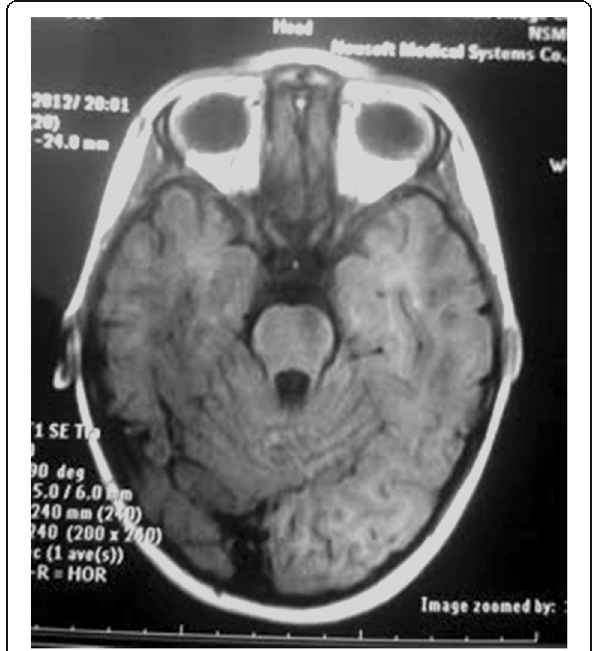
Fig. 2 MRI image of Patient II. It indicates mild cerebellar atrophy in an axial Image of brain